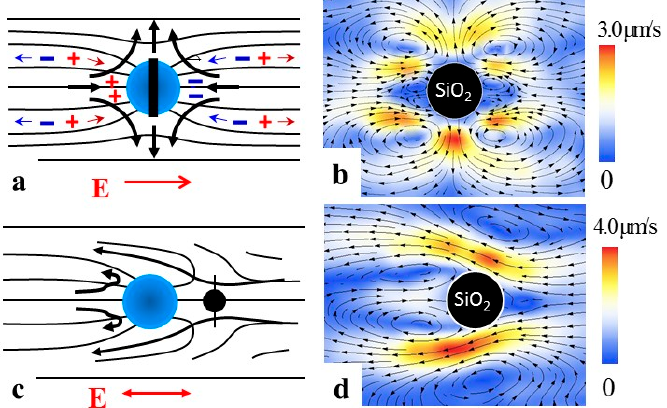
Figure 7. Liquid crystal-enabled electro-osmosis (LCEO) around a sphere with perpendicular anchoring and quadrupolar ( a , b ) or dipolar ( c , d ) director distortions; left column shows LCEO flows (thick arrows) and the director (thin lines). Right column shows experimental flow patterns around immobilized glass spheres of diameter 50 µ m; AC field, 5 Hz. Adapted with permission from Lazo et al. [25].